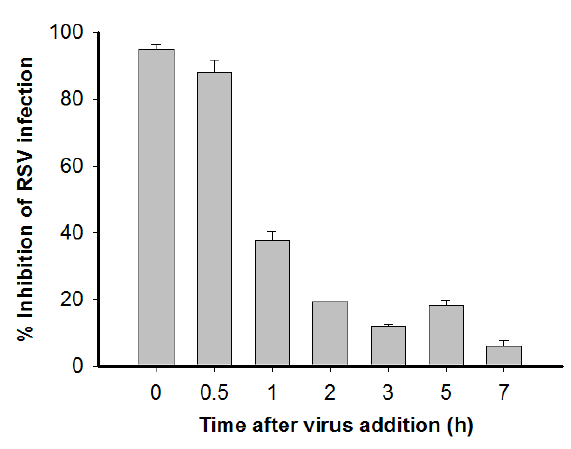
Figure 3. HSA-ML blocked RSV entry into the target cell. A time-of-addition assay was performed to determine the mechanism of action of ML-HSA. Each sample was tested in triplicate, and the experiments were repeated twice. The data from one representative experiment were presented in mean ± SD.